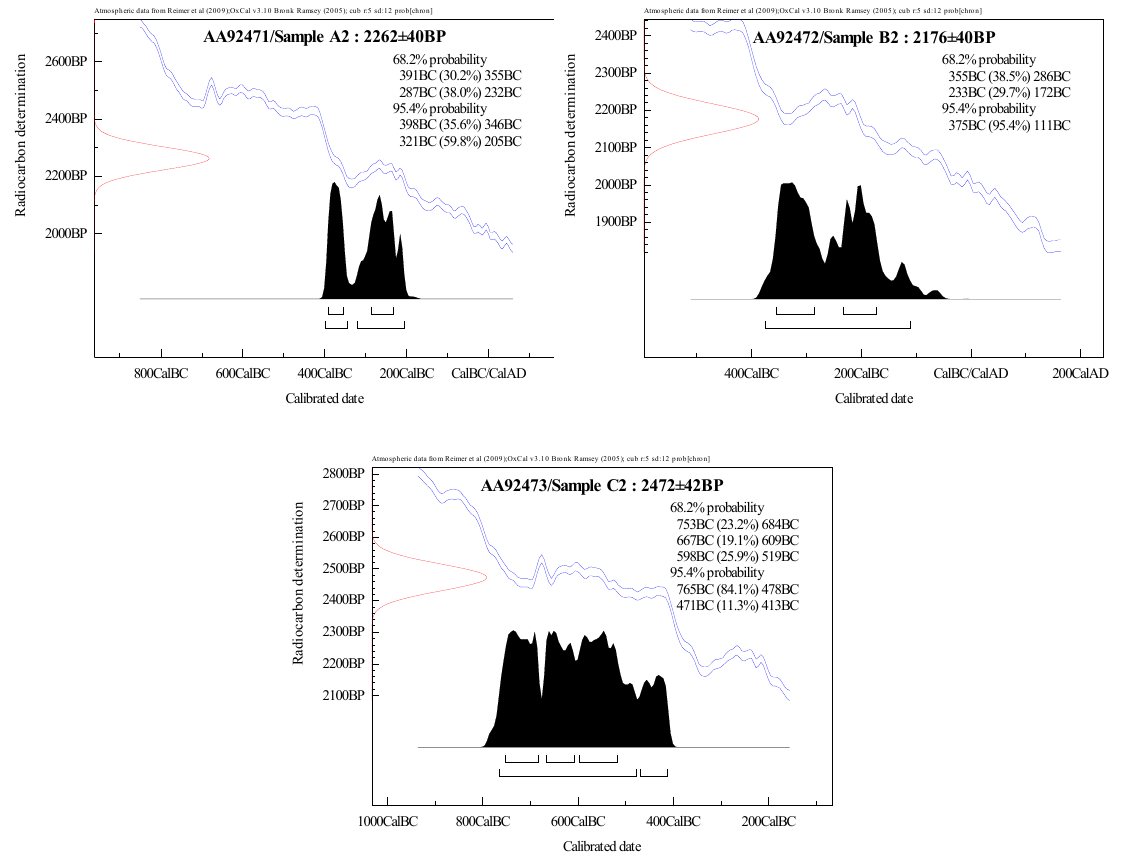
Figure 3. Calibrated radiocarbon dates from the tripartite coffins. Images courtesy University of Arizona, Department of Anthropology.